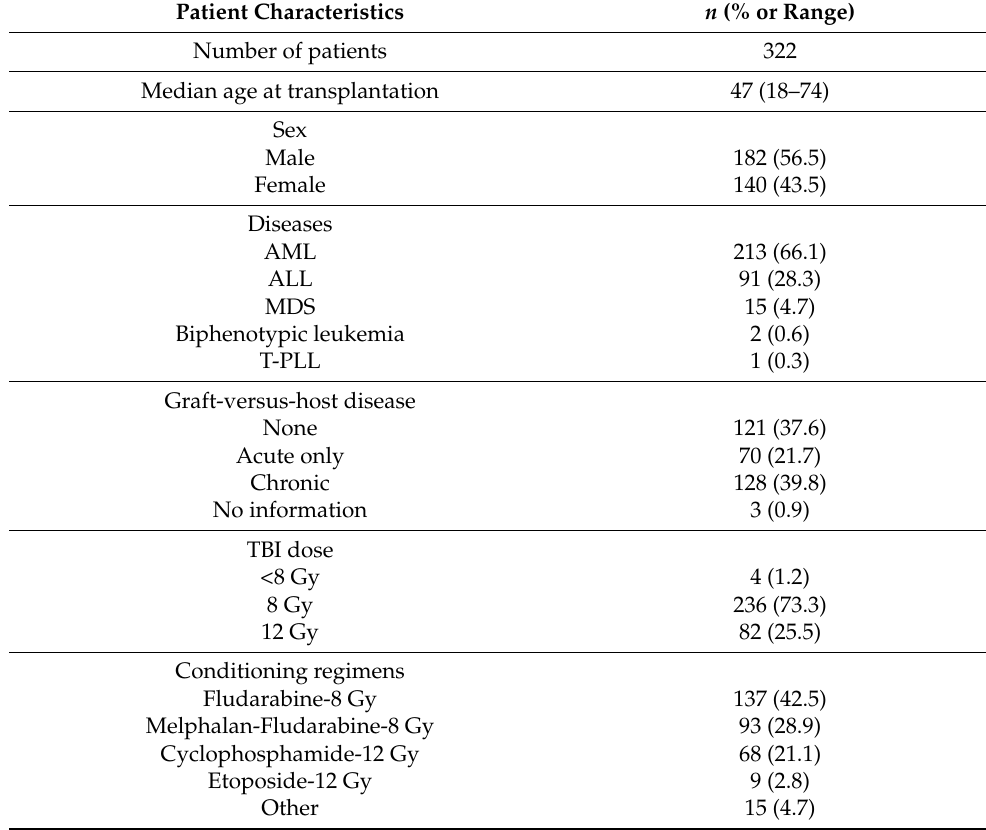
Table 1. Patient and treatment characteristics are given in absolute numbers and percentages